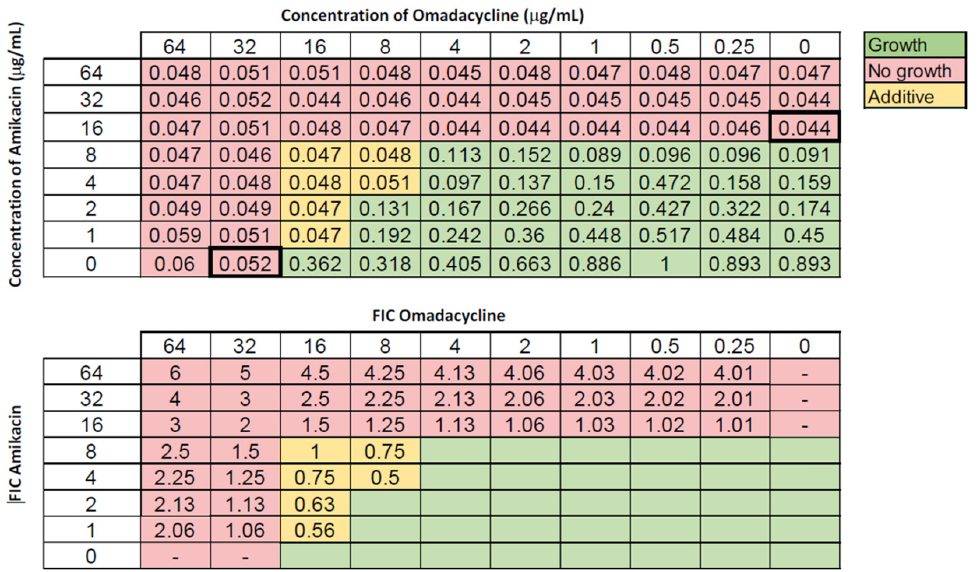
Figure 2. Representative checkerboard assay with omadacycline paired with amikacin. The XDR strain ACB9 was grown in the presence of varying concentrations of amikacin and omadacycline. Top: OD 600 measurements following 16 h of static growth at 37 °C. The MICs for each drug alone are outlined with a bold box. The pink boxes indicate wells with no growth and green-colored boxes indicate bacterial growth. The box in the bottom right corner contains no drug and serves as a growth control. Bottom: Fractional inhibitory concentrations (FICs) were calculated for each drug (concentration/MIC) and added together for all wells where no growth was observed. Yellow-shaded boxes indicate additive interactions (FICI between 0.5 and 1.0).